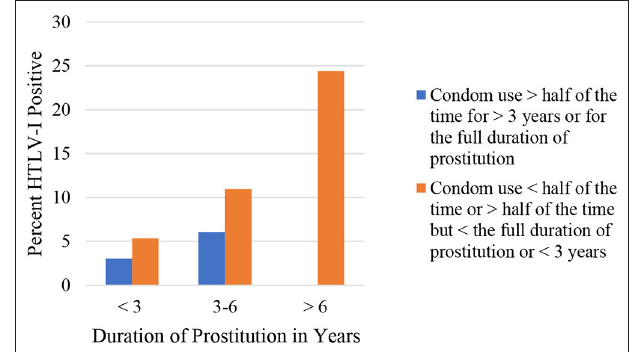
FIGURE 1 | Seroprevalence of HTLV-1 according to duration of prostitution and condom use, Gotuzzo et al. (24). FIGURE 2 | HTLV-1 prevalence according to time working as a FSW, Gotuzzo